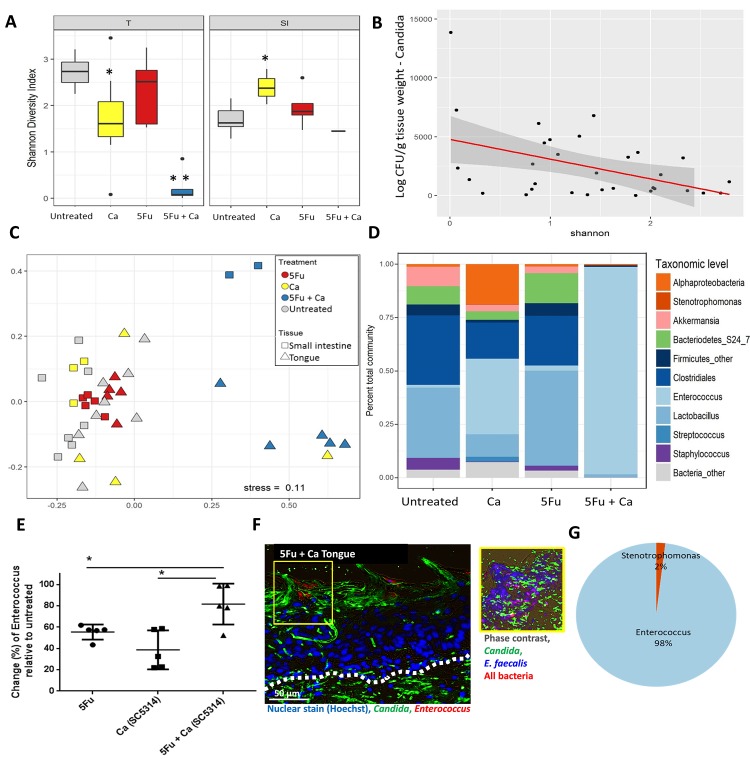
Mucosa-associated bacterial microbiota profiling.A: Microbial DNA was extracted from tongues (T) and small intestines (SI) of the same mice on day 8. The V4 hypervariable region of the 16S rDNA gene was amplified and sequenced. Box plot showing Shannon Diversity Index in untreated mice, mice receiving C. albicans SC5314 daily in the drinking water (Ca), mice receiving 5Fu alone and a combination of the two (5Fu+Ca). Mean diversity index values are shown from 5 mice in each group. In mice inoculated with C. albicans alone (Ca) bacterial diversity decreased in the tongue but increased in the small intestine mucosa (*p<0.05 for a comparison to untreated groups). For mice receiving 5Fu and C. albicans (5Fu+Ca) there was a significant further reduction in bacterial diversity in tongue but not small intestinal tissues (**p<0.001). B: Linear regression analysis of C. albicans CFUs plotted against the Shannon Diversity Index of the bacterial communities in the same tongues. Data include all mice receiving C. albicans SC5314 with or without chemotherapy, at all time points (5 mice/group, t = 2, 6 or 8 days, n = 30). This analysis showed higher C. albicans burdens correlating with lower bacterial diversity (R2 = 0.17, p<0.05). C: Beta diversity assessed by nonmetric multidimensional scaling (NMS) based on Bray-Curtis dissimilarities among four treatment groups. Shown are community structures in the untreated control, C. albicans alone, and the two chemotherapy groups (Untreated: grey, Ca: yellow 5Fu: red, 5Fu+Ca: blue; n = 5 mice/group) in tongues (triangles) and small intestines (squares) of the same mice. Results represent community structure differences at the end of the experimental period (day 8). Microbial communities clustered by type of treatment, indicating a significant effect of C. albicans in 5Fu treated mice. Samples in this group also clustered by site, indicating that the two sites harbor microbiomes with distinct global community structures and composition by day 8. The type of treatment explained 16% of the variability (p<0.01), whereas the site explained 8.5% of the variability (p<0.01) among samples. D: Mean relative abundance of OTU sequences assigned to one of the top 10% prominent taxa identified on mouse tongues, in each of the four treatment groups, at the end of the experimental period (day 8, n = 5 mice/group). Enterococcus was the most abundant taxon in both C. albicans-inoculated groups. However, relative abundance of this genus was more extensive in mice that also received chemotherapy, in which they represented ~98% of the total bacterial community. E: Validation of the bacterial microbiome sequencing data by qPCR. Genus level quantification was performed for Enterococcus on tongue tissues by qPCR. Data represent change in percentage of Enterococcus load in 5Fu, Ca (C. albicans SC5314) and 5Fu + Ca (SC5314) groups compared to untreated control mice. Mice receiving both 5Fu and C. albicans had significantly higher Enterococcus increase when compared to all other groups. Results are shown from 5 mice per group; bars represent means ± SEM. *p<0.001. F: Tongue tissue section from mice receiving 5Fu and C. albicans SC5314 for 8 days. Tissue sections were stained by immuno-FISH to simultaneously visualize C. albicans and endogenous bacteria. Left panel shows staining with the Enterococcus/Lactobacillus specific probe LAB158 (red), anti-Candida-FITC polyclonal antibody (green) and cell nuclei counterstained with Hoechst 33258 (blue). Note Candida invasion in the submucosal compartment (bellow the white dotted line). On the right panel immuno-FISH staining of a serial section from the same tissue is shown representing the biofilm area in yellow. Section was triple-stained with the all bacteria probe EUB338 (red), the Enterococcus faecalis specific probe ENFL84 (blue), and anti-Candida antibody (green). Note the almost complete overlap of the blue and red signals resulting in blue-purple staining bacteria representing E. faecalis. G: Identification of bacteria isolated from the tongues of mice after 8 days of receiving 5Fu and C. albicans SC5314. The V4 variable region of the 16S rDNA gene was amplified and sequenced by Illumina. 98% of the OTU sequences from five isolates aligned with the genus Enterococcus. All isolates were identified as E. faecalis with species-specific primers and PCR.